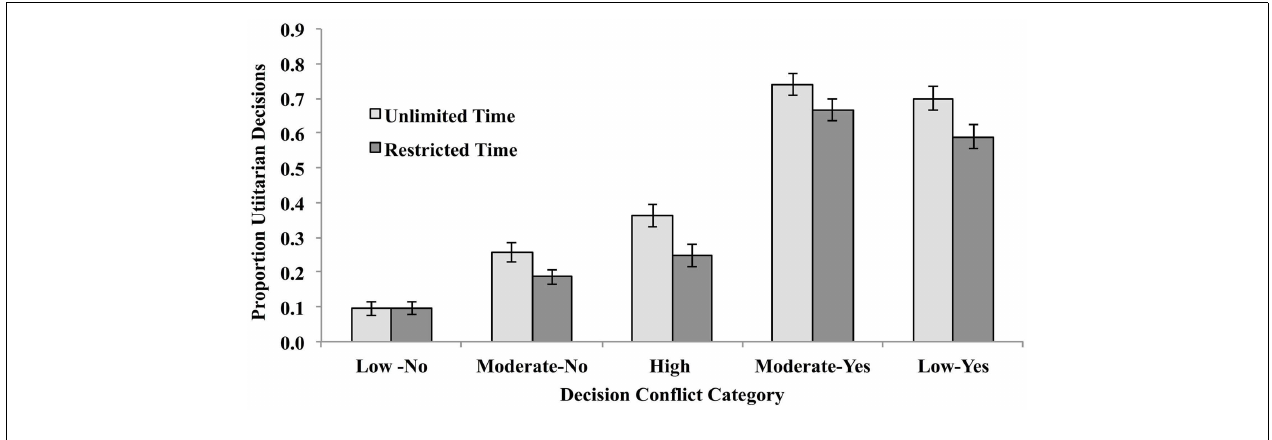
FIGURE 1 | Proportion utilitarian decisions made under unlimited- and reduced-decision time for high-conflict vignettes (long decision times and low inter-subject decision consensus), moderate conflict vignettes